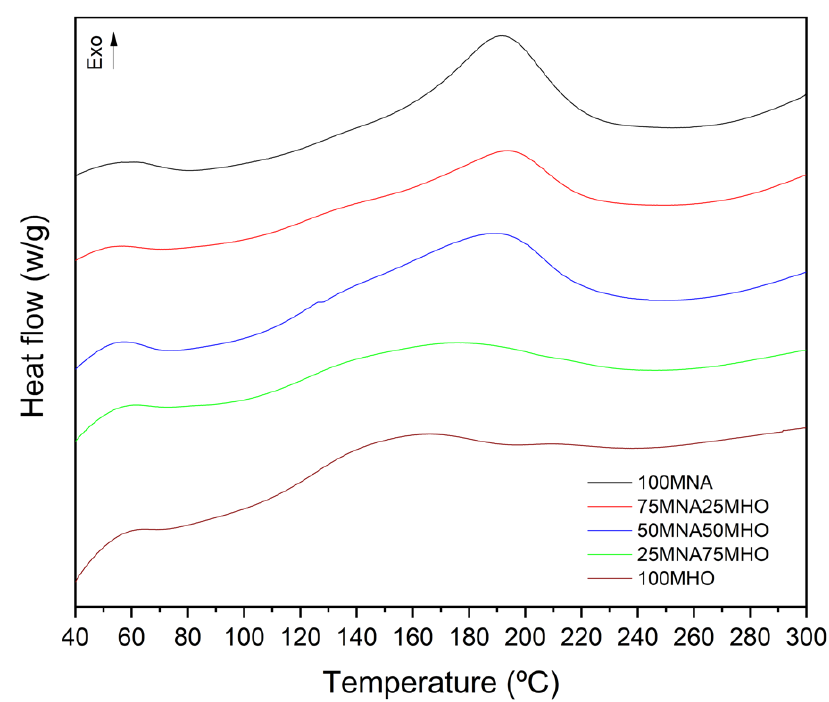
Figure 7. Comparison of the dynamic DSC thermograms of the curing process of different samples composed of the epoxidized hemp oil (EHO) and varying contents of methyl nadic anhydride (MNA) and maleinized hemp oil (MHO). Table 3. Main parameters of the DSC test of the curing process of different samples composed of the epoxidized hemp oil (EHO) and varying contents of methyl nadic anhydride (MNA) and ma- leinized hemp oil (MHO).